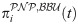
Representation of the configuration corresponding to the state variable πiPNP,BBU(t).The arrows illustrate the meaning of the notation.